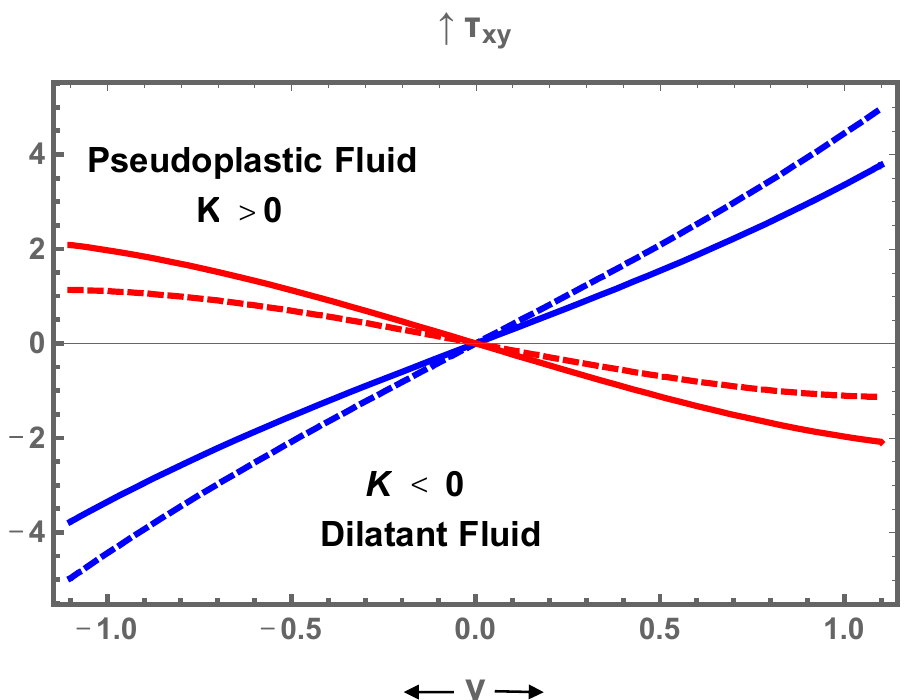
Figure 9. Display of shear stress profile via y for pseudoplastic and dilatant fluids.